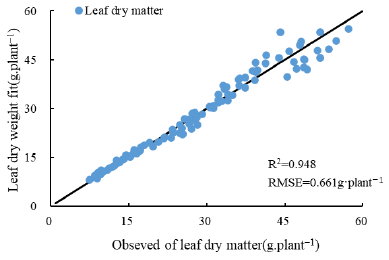
dry weight distribution ratio with LTE under 12 °C treatments. Note: Control represents the variation in fruit dry weight fit (proportion) per cucumber plant with the increase in LTE under normal growth conditions.